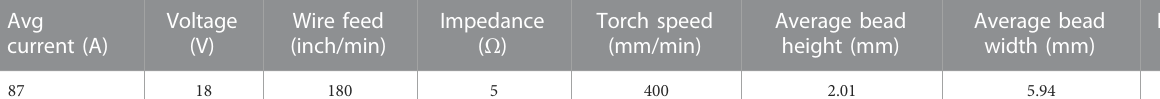
TABLE 3 Optimized print parameters used for solid structure printing via WAAM.